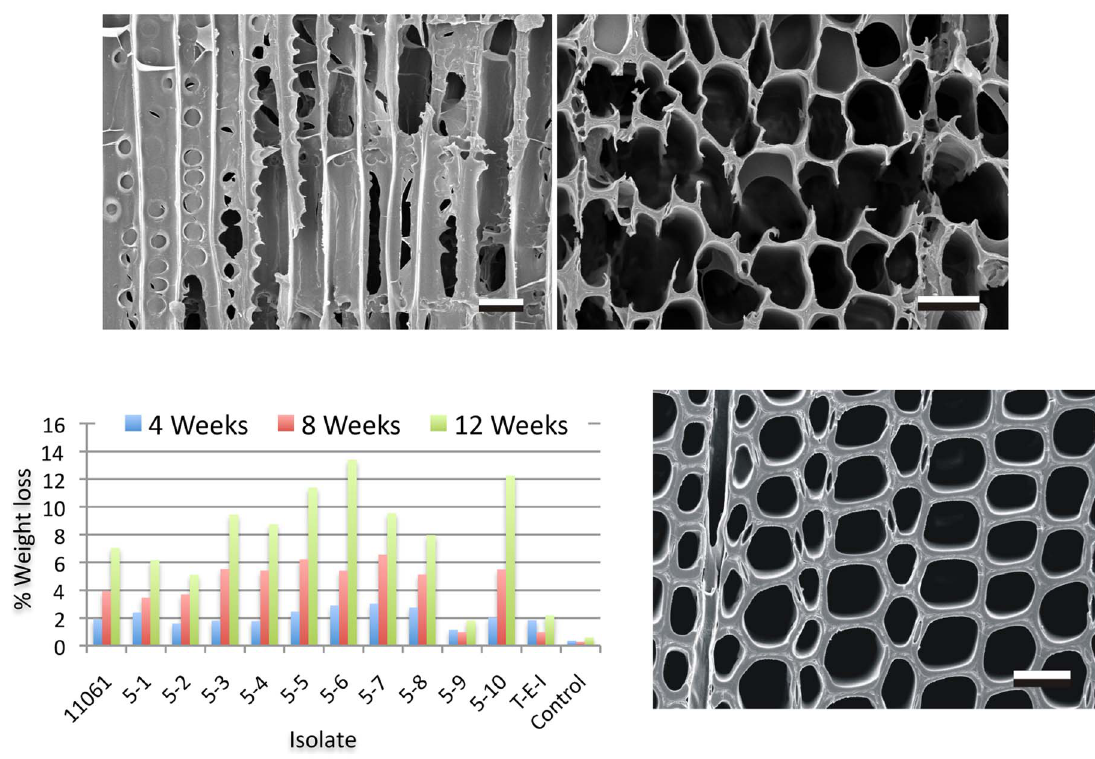
Figure 2. Wood decay characteristics. Comparative weight loss of parental strain 11061 and single basidiospore derivatives on colonized loblolly pine wood ( Pinus taeda ) wood wafers were determined after 4, 8 and 12 weeks incubation (bottom left panel) as described in Methods. Single basidiospore strain 5–6 also aggressively decayed birch and spruce (Text S1) and was selected for sequencing. Upper panels show scanning electron microscopy [68] of radial (left) and transverse (right) sections of pine wood tracheids that were substantially eroded or completely degraded by P. gigantea strain 5–6 by week twelve. Transverse section of sound wood (bottom photo) provides comparison. (Bar =40 m m).